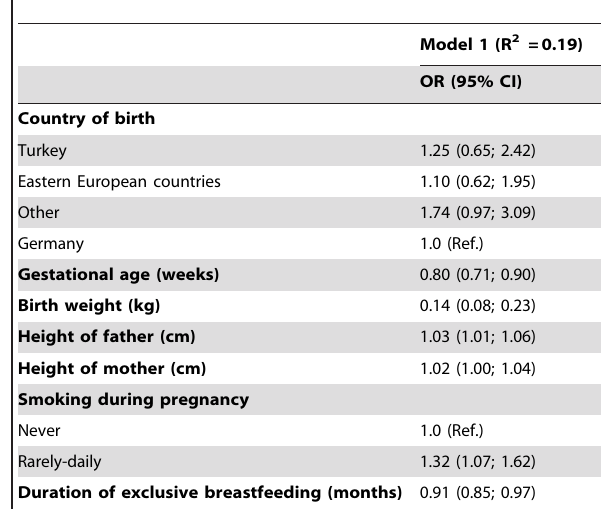
Table 4. Odds ratios (and 95% CI) for influence of migrant background on rapid weight gain between birth and six months of life, adjusted for covariates